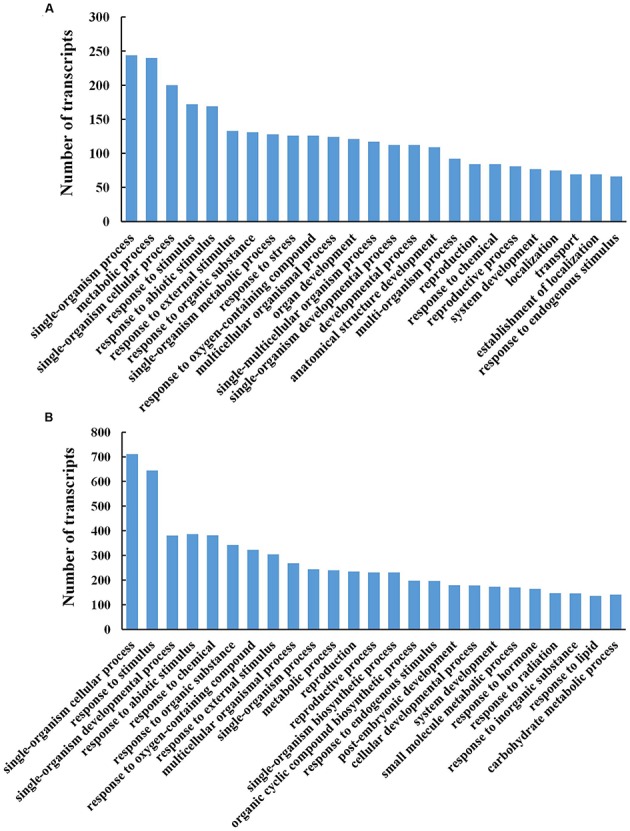
Gene ontology functional classification analysis of differentially transcribed genes (DTGs) during petal abscission. Histograms representing functional distributions (GO biological process class) of DTGs obtained from stage 3 compared to stage 1 (A), and from stage 5 compared to stage 3 (B). DTGs were determined using a cutoff ratio of >2 or <0.5 when comparing its expression in stage 3 to that in stage 1 (S3 vs. S1), and/or in stage 5 to that in stage 3 (S5 vs. S3).